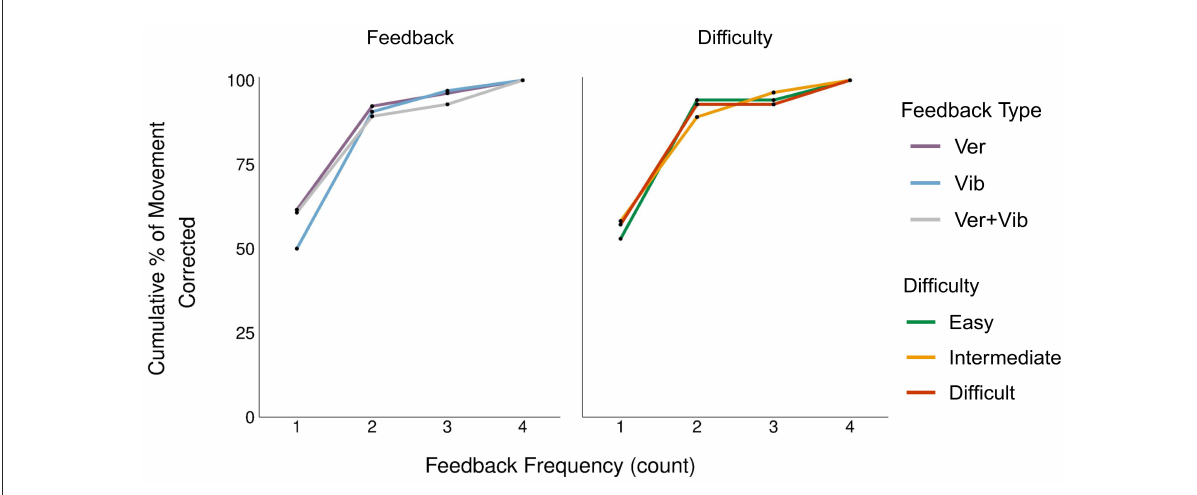
FIGURE6 Frequency of feedback events required for pose correction (cumulative % of movement corrected).